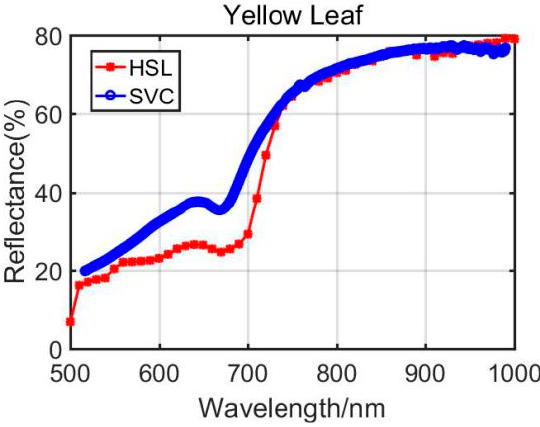
Figure 9. Aloe yellow leaf spectral profiles.